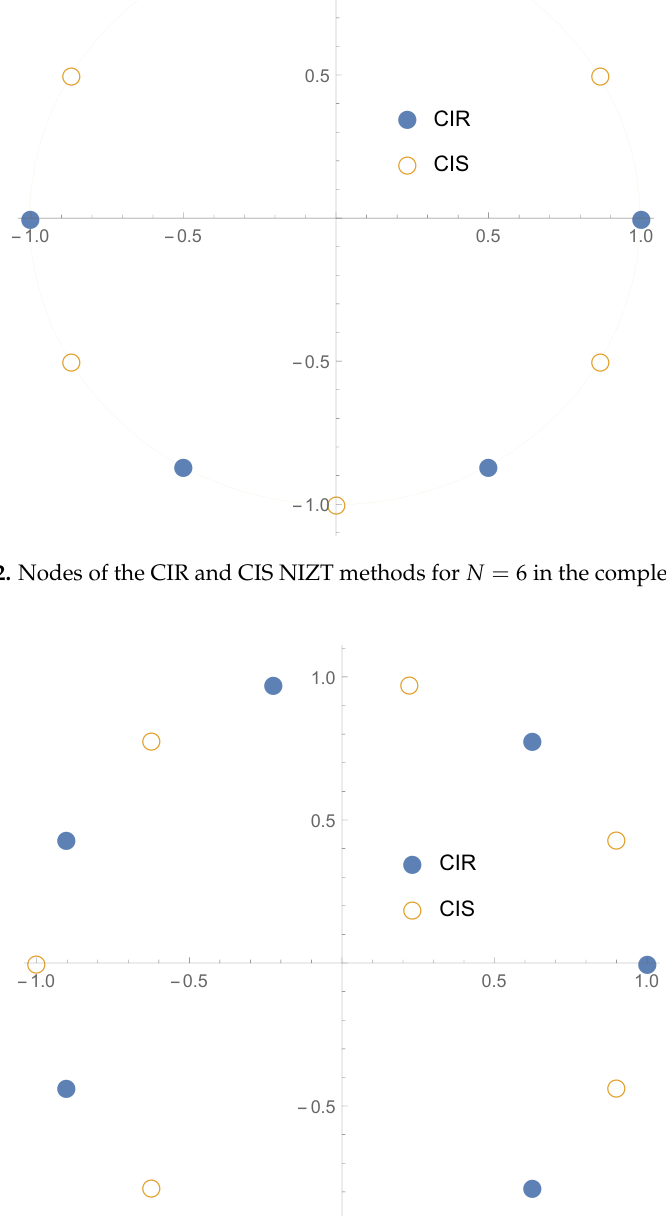
Figure 1. Sections shifted and summed according to (15) when T < N